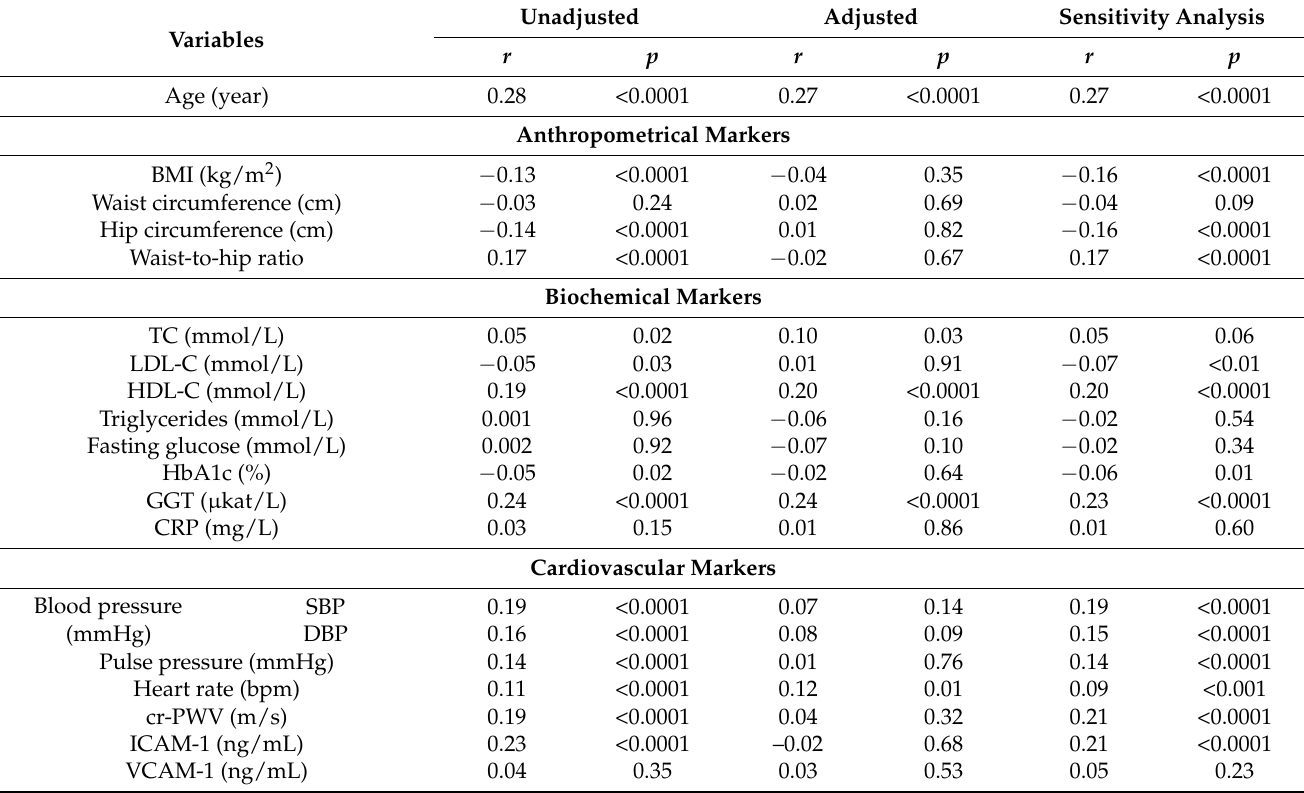
Table 3. Spearman correlations between Hcy and characteristics of